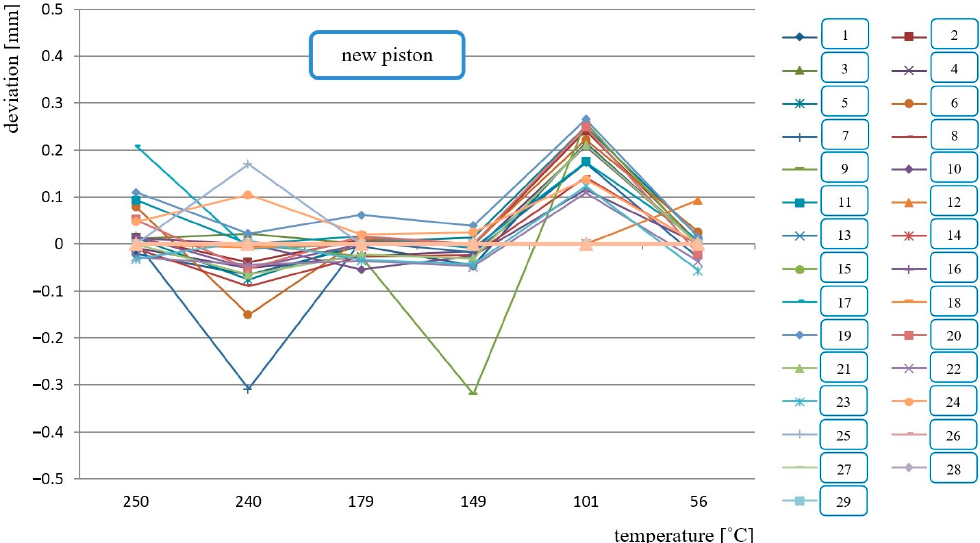
Figure 13. Deviations from the reference measurement (at a temperature of 21 °C) at the individual measurement points of the new piston.